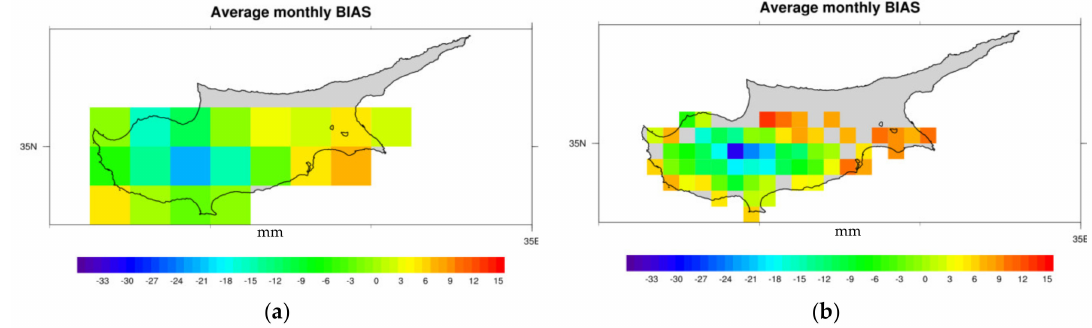
Figure 8. Monthly bias for both precipitation products for the study period: ( a ) TRMM and ( b ) GPM.